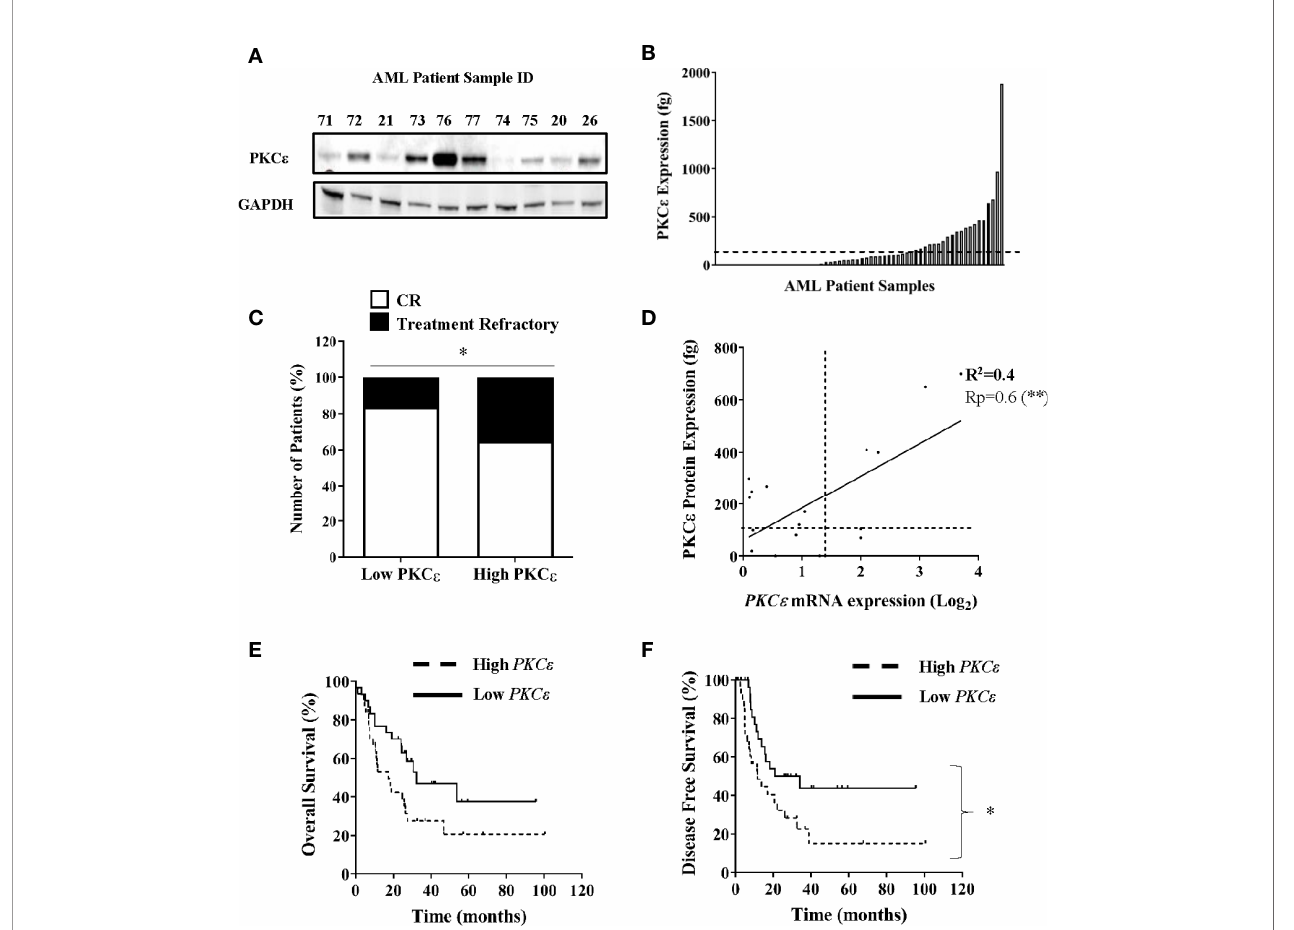
FIGURE 1 | PKC ϵ is frequently overexpressed in AML and is associated with poor patient outcomes. (A) Example western blot showing PKC ϵ (MW-84kDa) protein expression in AML patient samples from the AML14 and AML15 trials ( Supplementary Table 1 ). PKC ϵ expression was detected using the C-15 Santa Cruz antibody ( Supplementary Table 2 ) and is shown alongside GAPDH (MW-36kDa) which was used as a loading control (6c5 antibody; Santa Cruz; Supplementary Table 2 ). (B) Bar chart showing PKC ϵ protein expression in AML patients (fg protein/1000 cells; n=70). PKC ϵ expression was quanti fi ed by western blot. Dotted line shows threshold for overexpression [>2SD from mean of normal CD34 + BM blasts (n=4)]. (C) Proportion of patients achieving CR vs refractory disease following induction chemotherapy for patients with high (overexpressing) and low PKC ϵ (<threshold for overexpression); *p < 0.05 using Fisher ’ s Exact test. (D) Correlation between PKC ϵ mRNA expression (Log 2 ), determined by Hu133A GeneChip ® microarray analysis and protein expression (as A), in AML patients (n=18). Dotted lines show threshold for mRNA and protein overexpression compared to normal CD34 + BM blasts, Pearson ’ s correlation analysis (Rp) 0.6; 95% CI (0.24-0.85); **p < 0.01. (E) Impact of PKC ϵ expression on OS and (F) Impact on DFS for AML patients from the TCGA dataset (36), where high (n=31) and low (n=30) PKC ϵ expression were de fi ned as the upper and lower quartiles respectively [High PKC ϵ : median survival- 17.4 months vs low PKC ϵ - 32.3 months, HR 1.89 95%CI